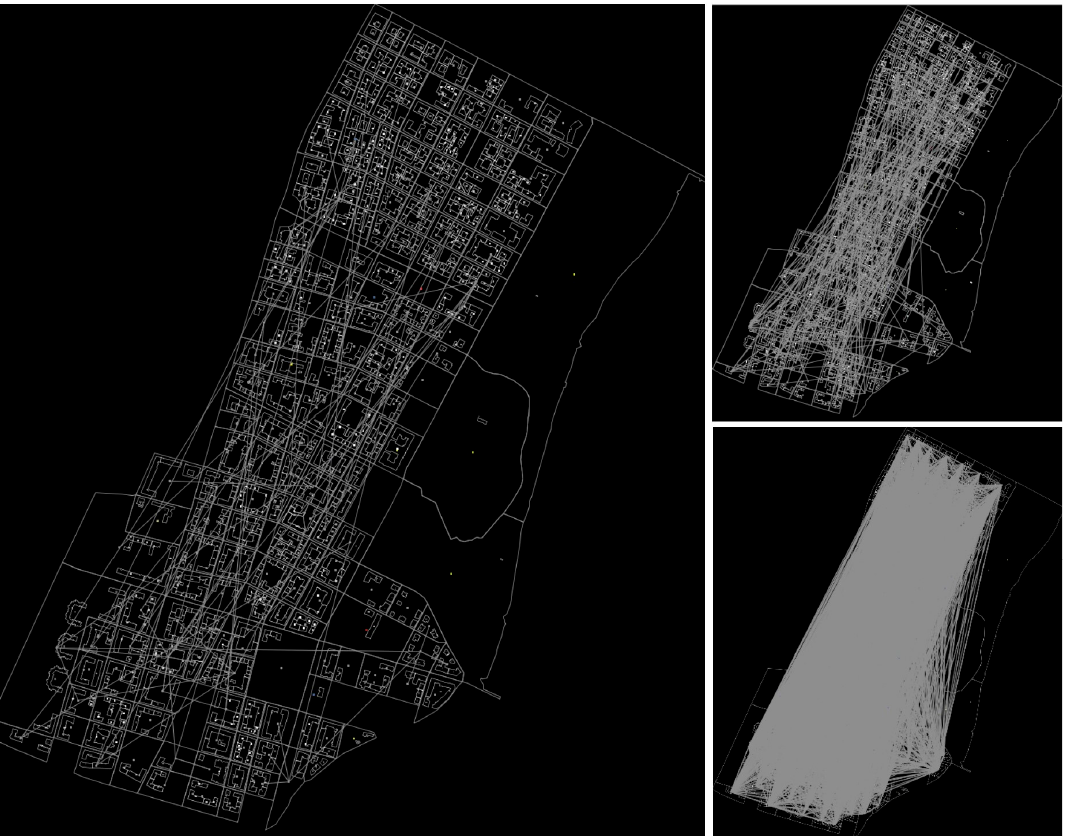
Figure 4. Dynamic network formation of the agents in the neighborhood following